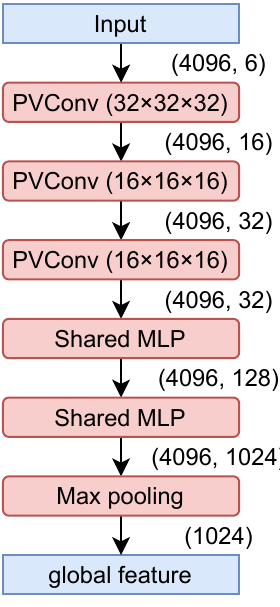
Figure 3. Architecture of the proposed network.